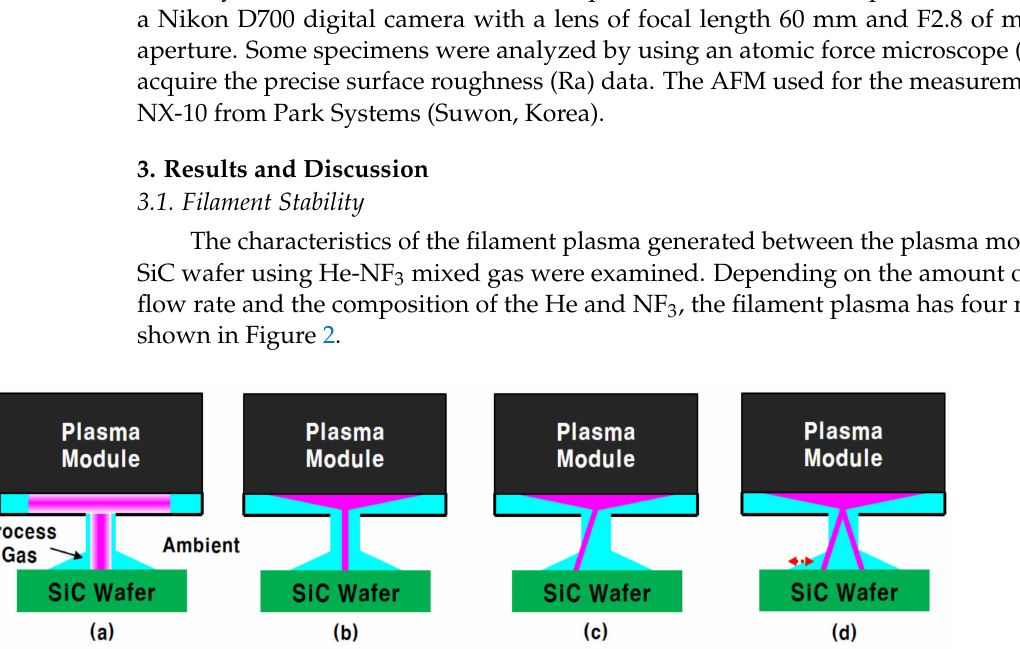
Figure 2. Filament plasma modes of ( a ) glow jet (GJ), ( b ) normal filament (NF), ( c ) crooked filament (CF), and ( d ) jittering filament